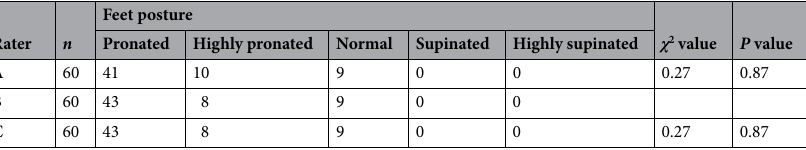
Table 7. Classification of the feet postures in the three moments of assessment. A, rater (J Y); B, rater (Z M); C, rater (J Y) approximately one week apart.